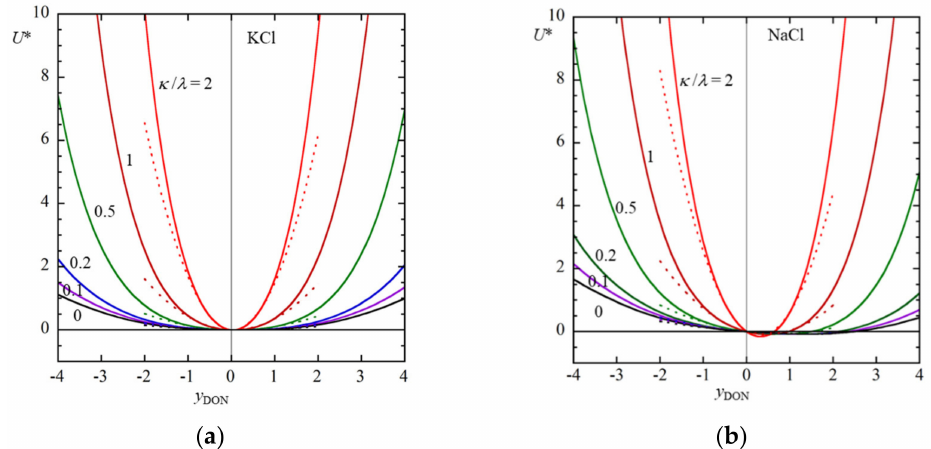
Figure 2. Scaled diffusiophoretic mobility U * of a large soft particle with a thick polyelectrolyte layer as a function of the scaled Donnan potential y DON for several values of κ / λ in an aqueous KCl solution ( β = − 0.02) ( a ) and in an aqueous NaCl solution ( β = − 0.2) ( b ). Solid lines are results obtained with Equation (52). Results obtained with a low potential approximation with Equation (56) are also given as dotted